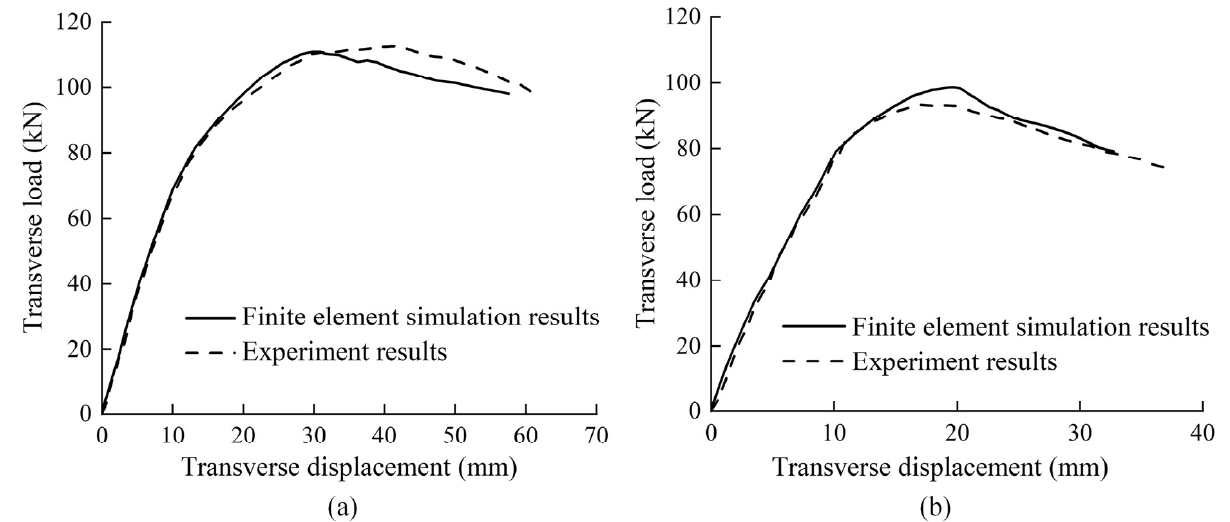
Figure 4. Comparison of load–displacement curves of finite element simulations versus experiment records: ( a ) Specimen A4, ( b ) Specimen B5.